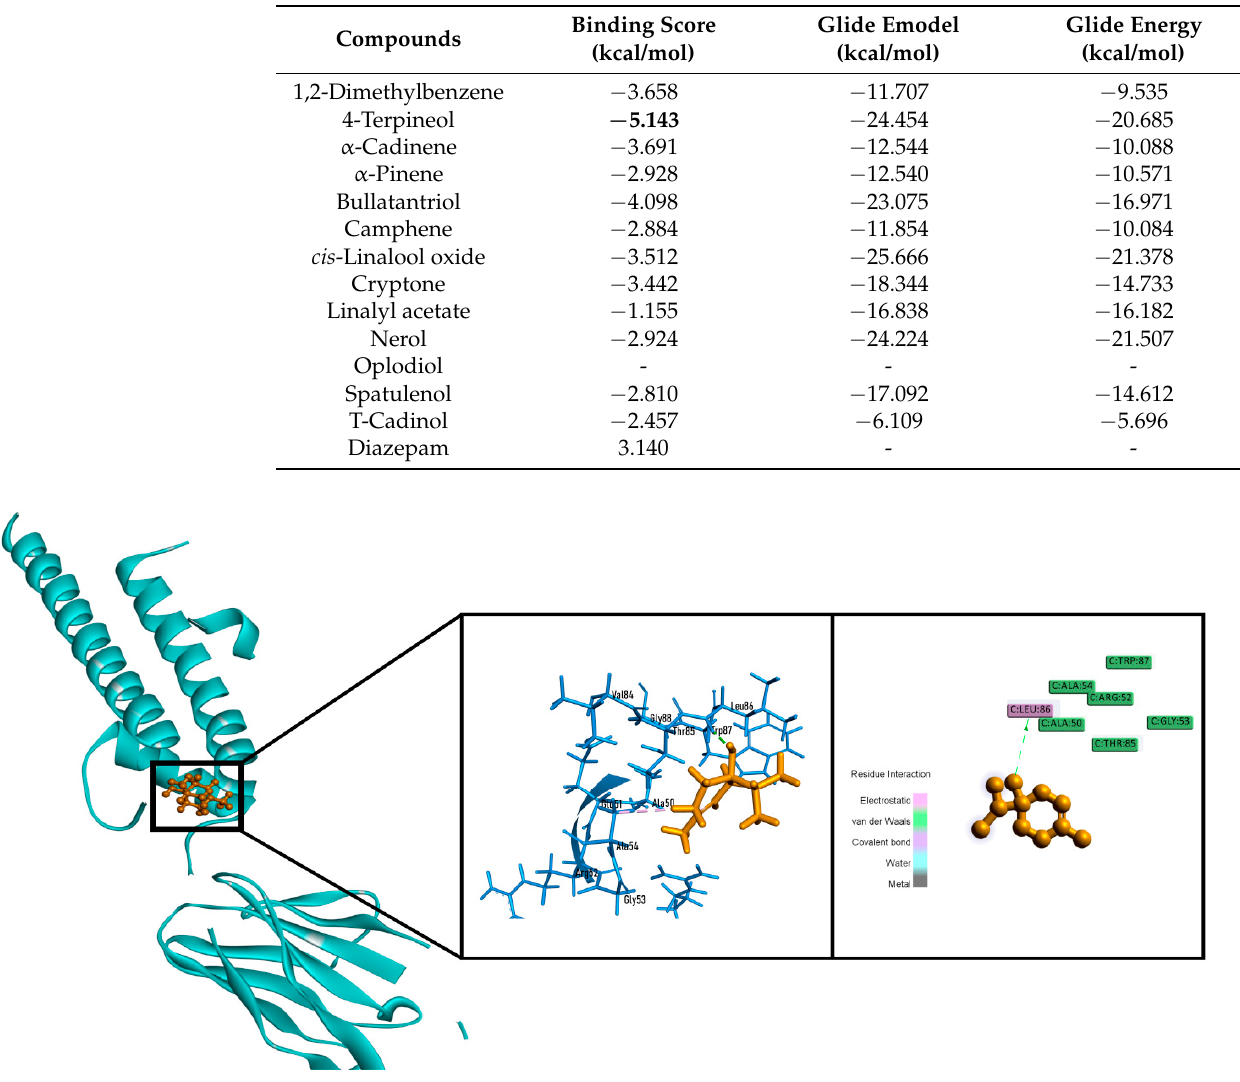
Figure 8. Best docked poses and 2D interactions of 4-terpineol with potassium channel receptor (PDB: 4UUJ) for anxiolytic activity.